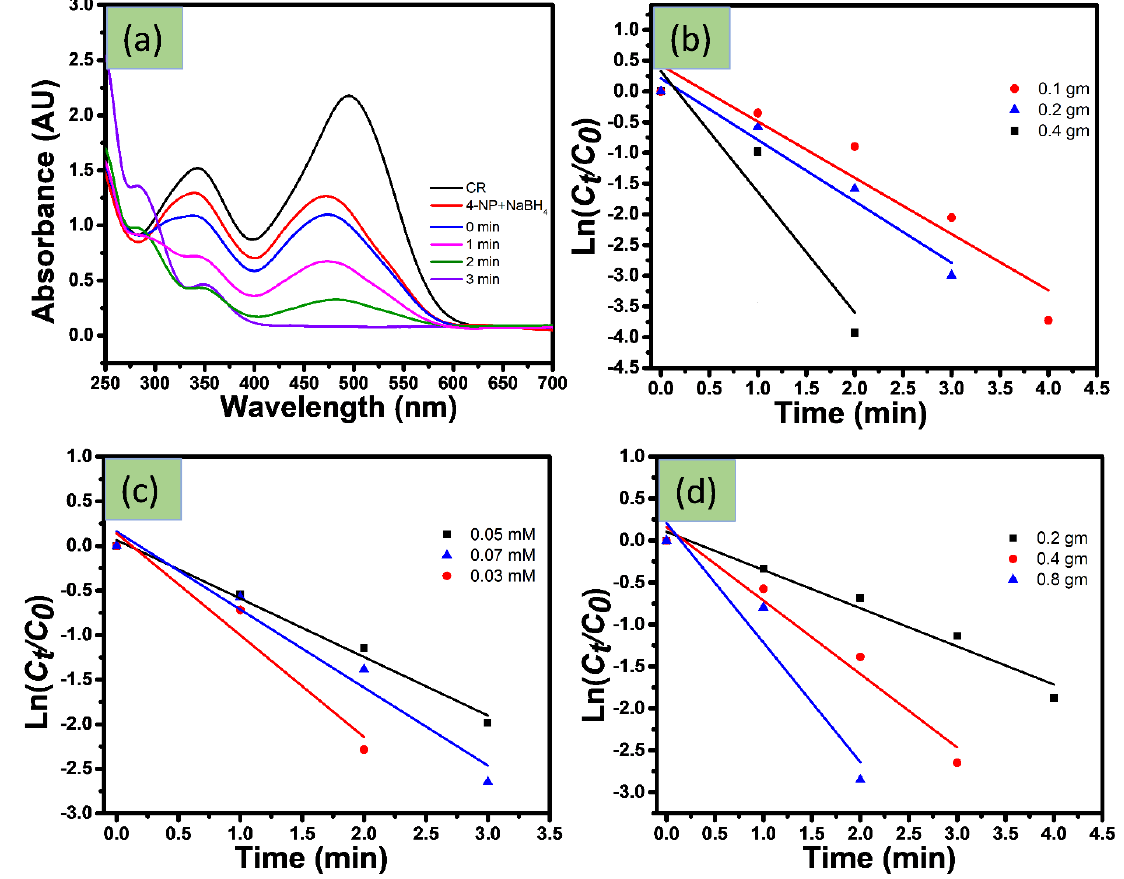
Figure 8. UV–visible spectra of CR dye reduction with NaBH 4 /Sn-Gd 2 O 3 @GH ( a ). Optimization of CR dye degradation. The plot of ln (Ct/C0) versus time for CR dye by changing amount of Sn-Gd 2 O 3 @GH catalyst ( b ). Different concentrations of CR dye ( c ) and changing the amount of NaBH4 ( d